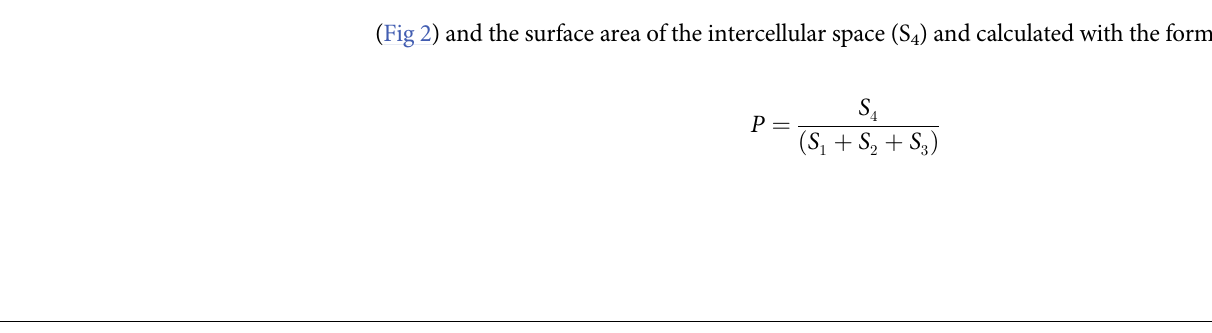
PLOS ONE | https://doi.org/10.1371/journal.pone.0278473 December1,